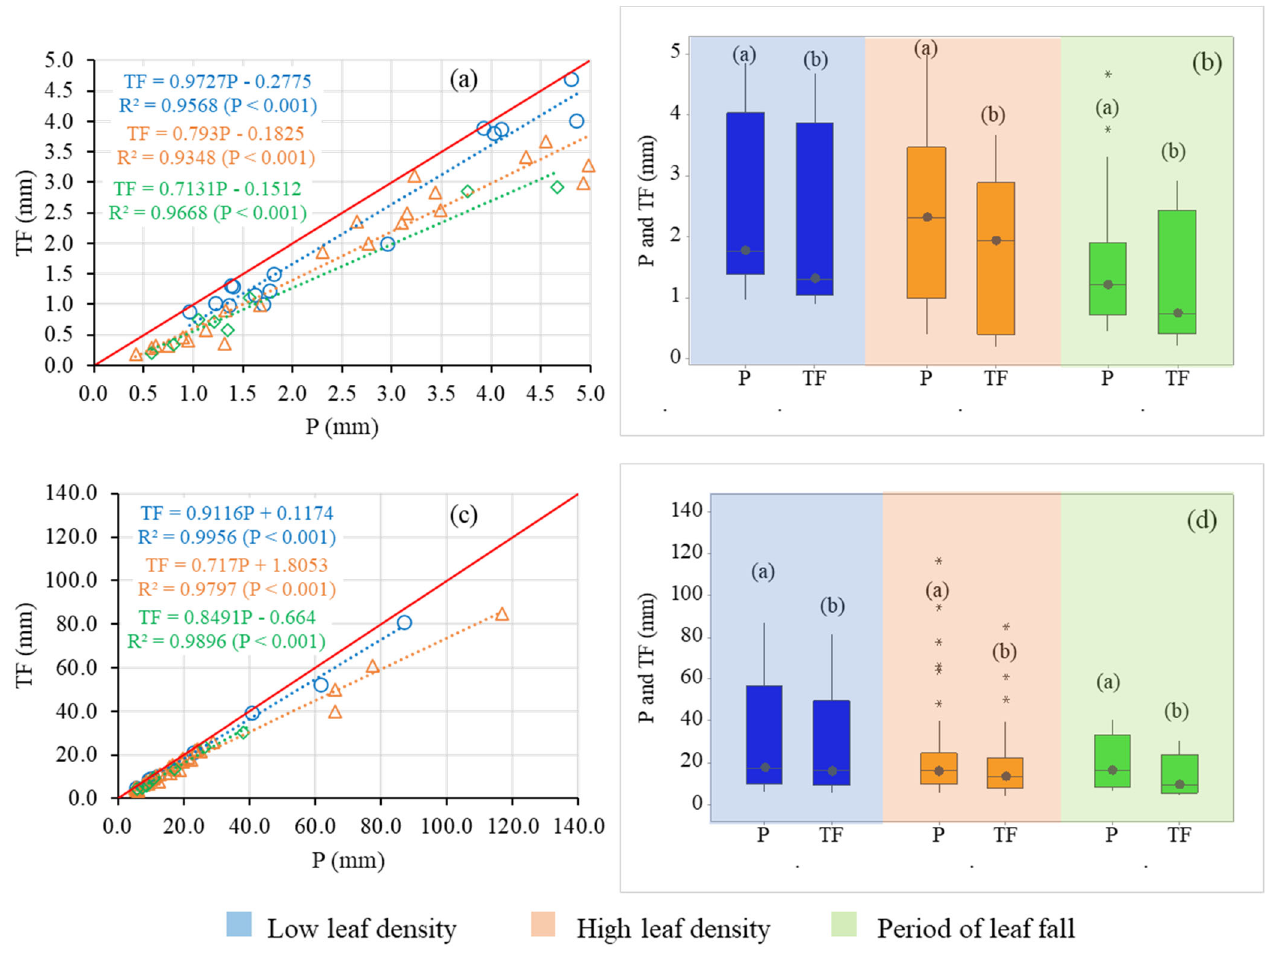
Figure 4. Frequency of occurrence of the monitored rain events.